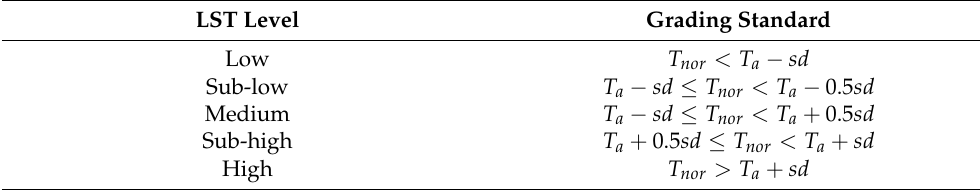
Table 2. Land surface temperature (LST) grading